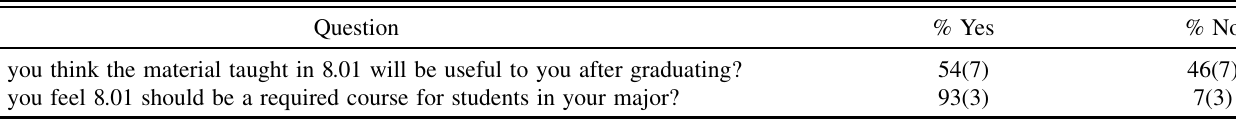
TABLE IX. Responses to questions on our demographic survey. Course 8.01 is freshman